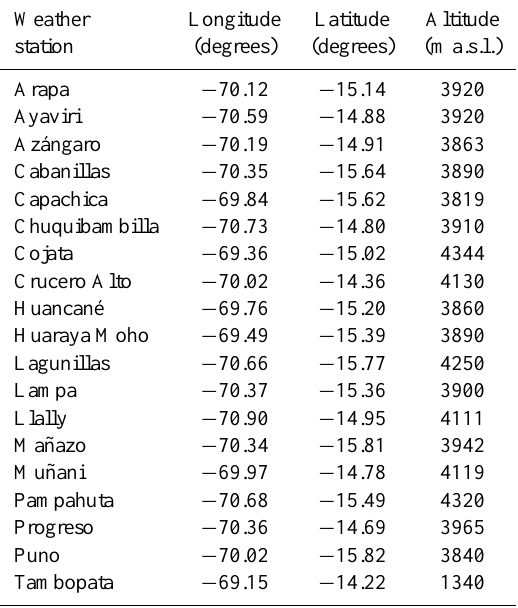
Table 1. Weather station locations an altitudes.